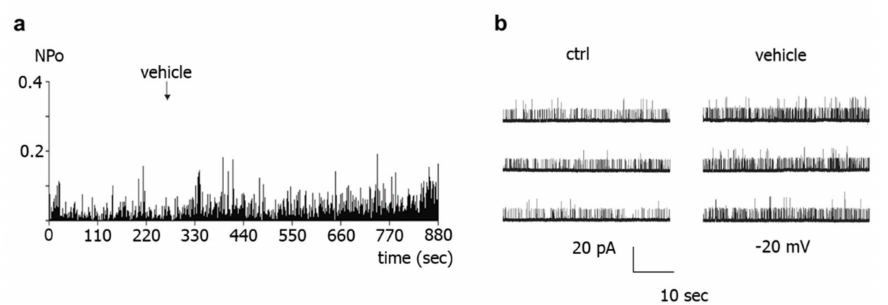
Figure 6. Effect of experimental bath solution (vehicle) on excised BK channels of rat tail artery smooth muscle cells. ( a ) Example of a diary plot of BK channel activity (NPo) at − 20 mV with application of vehicle (at arrow). ( b ) Examples of traces of BK channel activity at − 20 mV taken from the same patch as in ( a ) during control (ctrl) and addition of vehicle.